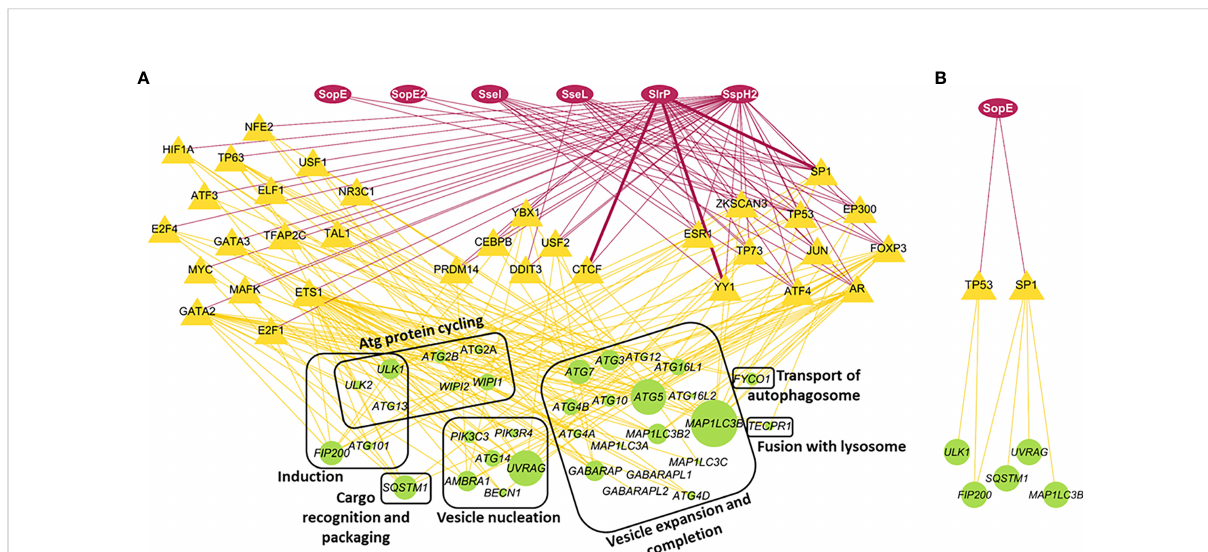
FIGURE 1 Interaction network between selected Salmonella Typhimurium effectors, host cell transcription factors and autophagy core genes. (A) Network analysis of potential interactions between Salmonella and host autophagy. Red ovoid nodes are the selected Salmonella effector proteins. Red edges are PPI predictions. Thin edges were predicted by one of the three methods. Thick edges were predicted by two of the three methods. Yellow triangular nodes are host transcription factors that Salmonella effectors can in fl uence. These are clustered according to the number of Salmonella effectors they are targeted by. Yellow edges re fl ect transcriptional regulation of core autophagy genes (round green nodes) by the transcription factors. The size of the green nodes is proportional to the number of transcription factors they are connected to. (B) Subnetwork illustrating the potential interaction of the Salmonella effector SopE with transcription factors affecting speci fi c autophagy core genes. The same layout was used here as for the large